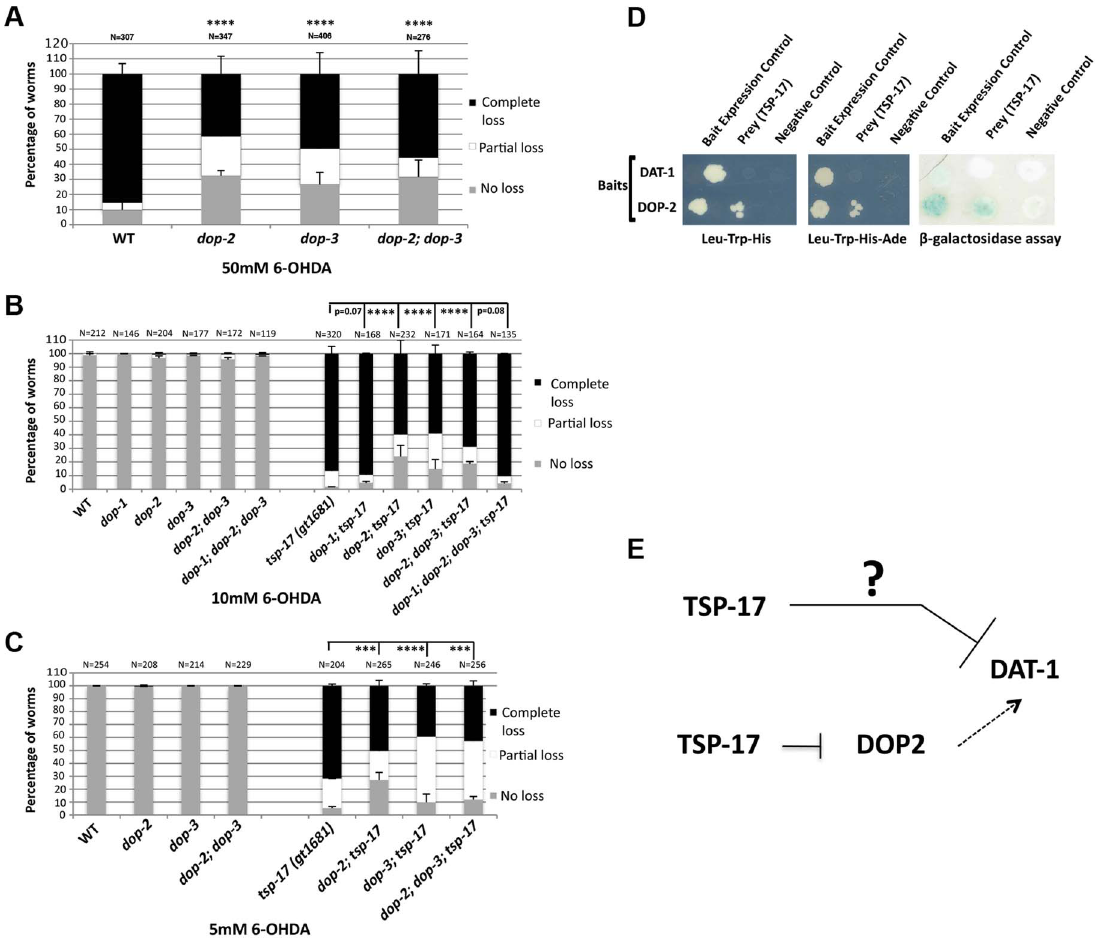
Figure 7. Dopamine receptors act antagonistically to modulate the sensitivity of tsp-17(gt1681) mutants to 6-OHDA. Worms of the indicated genotypes were intoxicated with A . 50 mM, B . 10 mM 6-OHDA and C . 5 mM 6-OHDA and scored for neurodegeneration 72 h post intoxication. Experiments were done in triplicate and the average data is presented. N, total number of animals examined for each strain. Error bars represent the standard error of the mean. Asterisks represent statistically significant differences (***p , 0.0001, ****p , 0.00001). D . Evidence for a direct interaction between DOP-2 and TSP-17. Growth on -Leu, -Trp, -His (left panel) and -Leu, -Trp, -His, -Ade (middle panel) plates is shown. The right panel depicts a b -galactosidase assay. E . Working model as to how TSP-17 might interact with DAT-1 and DOP-2 to modulate level of DAT-1 activity. Arrows indicate activation. T-bars indicate repression. The question mark indicates that we do not know the mechanism of DAT-1 inhibition by TSP- 17.